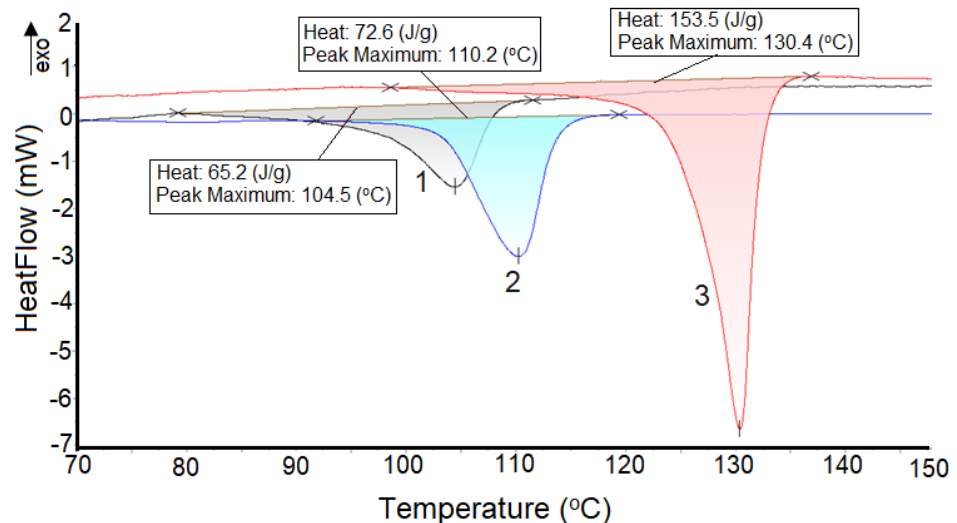
Figure 3. Melting endotherms from three different polyethylene materials: 1 — XLPE insulation (from I&C cable); 2 — LLDPE insulation (from multiconductor instrumentation); 3 — HDPE insula- tion (from multiconductor instrumentation).